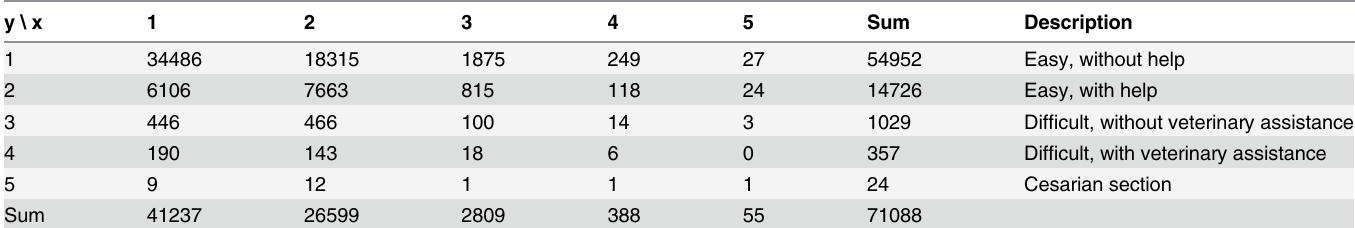
Table 1. Cross-tabulation of calvings and calving code.